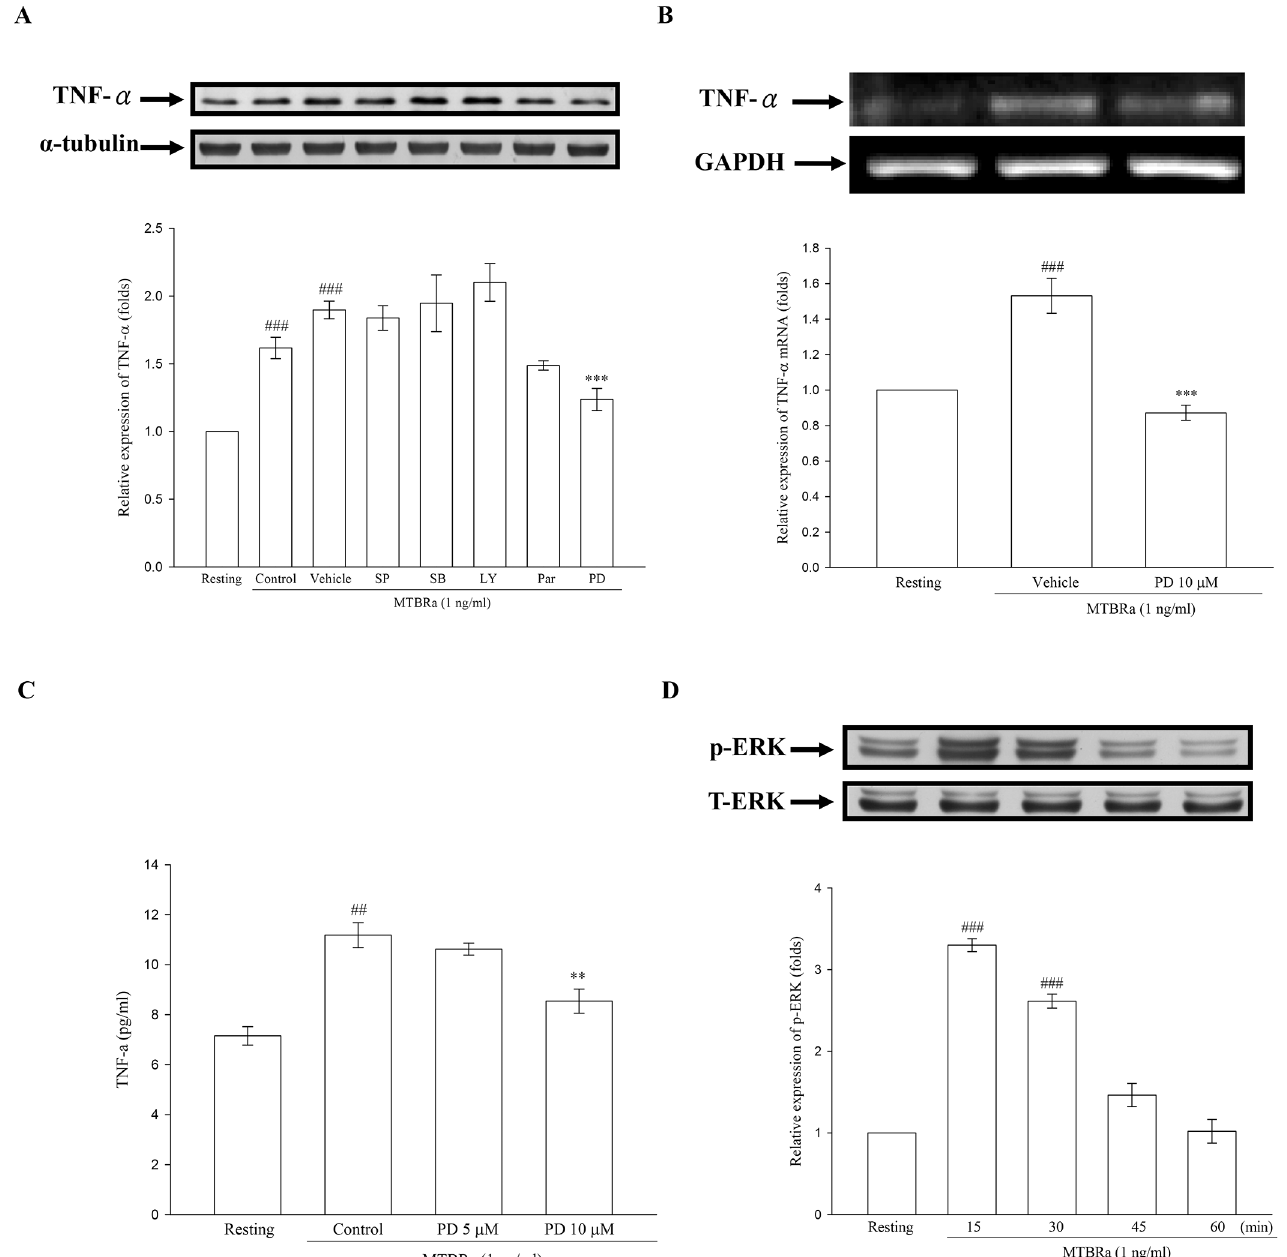
Fig 4. Signal pathways mediating TNF- α expression in MTBRa-stimulated human PMCs. (A), MeT-5A cells were pretreated with vehicle, SP600125 (SP), SB20358 (SB), LY294002 (LY), Parthenolide (Par), PD98059 (PD), respectively, then stimulated with MTBRa (1 ng/ml) for 24 h. TNF- α protein expression was assessed by Western blot. (B), MeT-5A cells were pretreated with PD98059 (PD) (10 μ M), followed by stimulation with MTBRa (1 ng/ml) for 4h. TNF- α mRNA concentrations were analyzed by RT-PCR. (C), MeT-5A cells were pretreated with PD98059 (PD) (5 and 10 μ M) following stimulation with MTBRa (1 ng/ml) for 6 h, supernatant TNF- α level was analyzed by ELISA. (D), MeT-5A cells were treated with MTBRa (1 ng/ml) for the indicated times. ERK expression was analyzed by Western blotting with antibodies specific for phosphorylated or total proteins. ## p < 0.01, ### p < 0.001 compared with the resting group; ** p < 0.001, *** p < 0.001 compared with the vehicle (DMSO) group. PMC, pleural mesothelial cell; TLR, toll-like receptor; MTBRa, heat-killed M . tuberculosis H37Ra; TNF, tumor necrosis factor; ERK, extracellular-signal-regulated kinase.